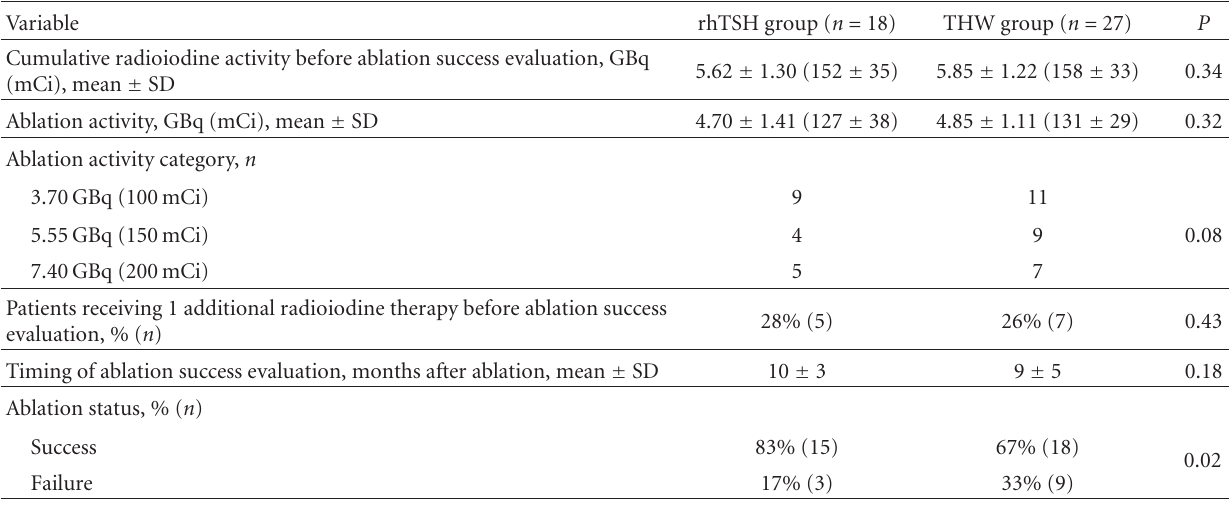
Figure 1: Initial treatment and follow-up regimen in patients with thyroid cancer included in the study. Thyroid surgery represents time zero; other numbers refer to months after surgery. Dx, diagnostic; rhTSH, recombinant human thyrotropin; Tg, thyroglobulin; TgAb, antithyroglobulin antibodies; TSH, thyroid-stimulating hormone; US, ultrasonography. Table 2: Ablation characteristics by patient